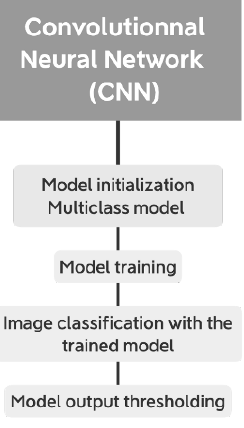
Figure 3. Convolutional neural network diagram.